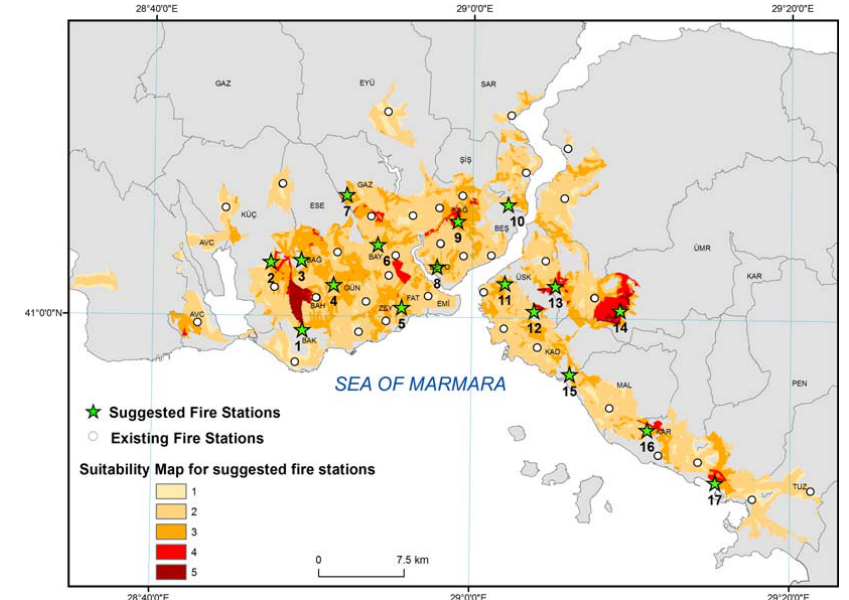
Figure 5. Suitability map for suggested fire stations. Fig. 5. Suitability map for suggested fire